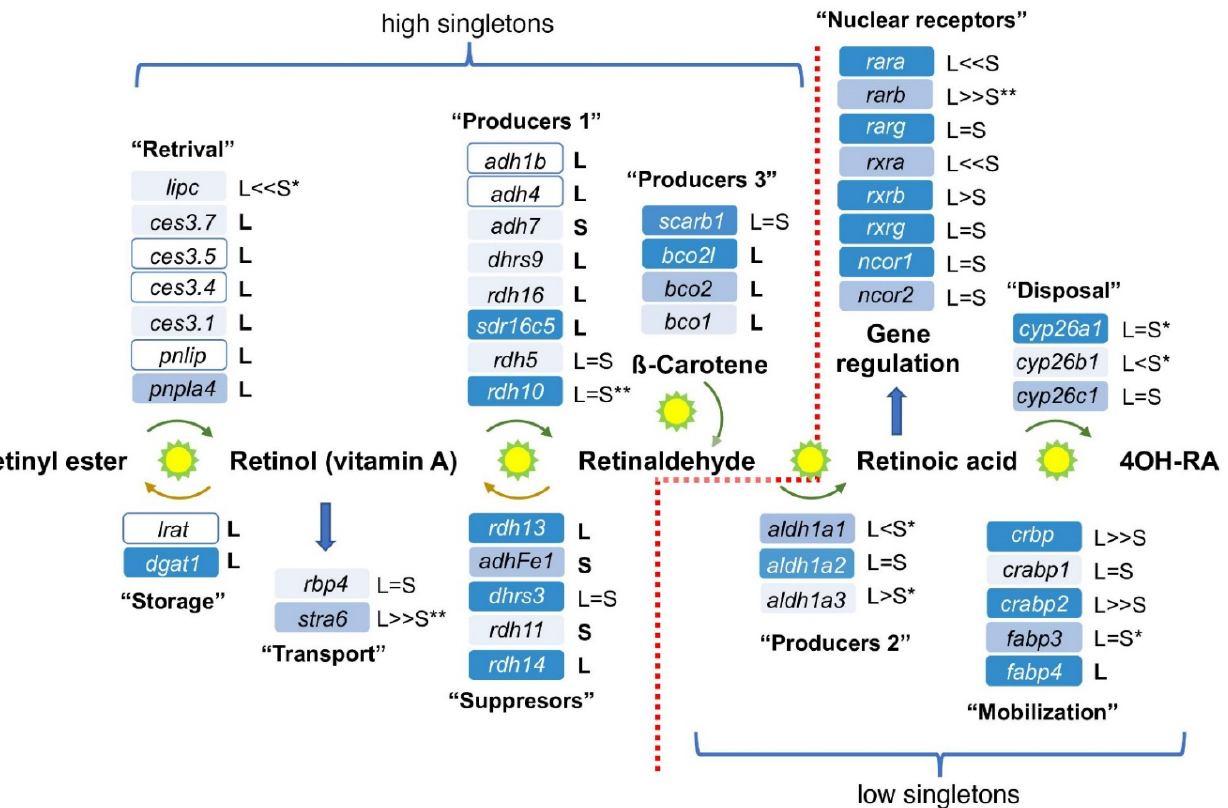
Figure 1. Evolutionary conservation of the RA metabolic and gene-regulatory network genes in Xenopus laevis . Composition of the RA metabolic and gene-regulatory network in the Xenopus laevis genome based on KEGG and Xenbase database analysis and literature searches [44,52]. Expression of the RA network components during gastrula stages was summarized from our own and published transcriptomic datasets. The relative expression shown (blue shades) during gastrula stages is based on Session et al. [32]. Dark blue, ≥10 TPM; middle blue, 0.5–10 TPM; light blue, ≤0.5 TPM; white, no data in the transcriptomic dataset. The homoeolog/singleton status of each gene is marked (L and/or S). The relative expression levels between homoeologs are summarized: =, similar expression levels; <, 3–6 fold difference; <<, more than 6 fold difference. Asterisks indicate whether temporal expression patterns of the homoeologs are similar (no asterisk), partially divergent (*), or highly divergent (**).